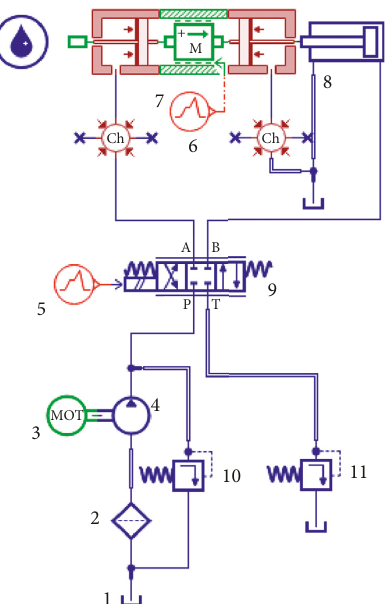
Figure 4: AMESim modeling of the single hydraulic system. 1, oil tank; 2, oil filter; 3, motor; 4, hydraulic pump; 5, signal source 1; 6, signal source 2; 7, balance cylinder; 8, loading cylinder; 9, elec- tromagnetic directional valve; 10, overflow valve 1; 11, overflow valve 2.